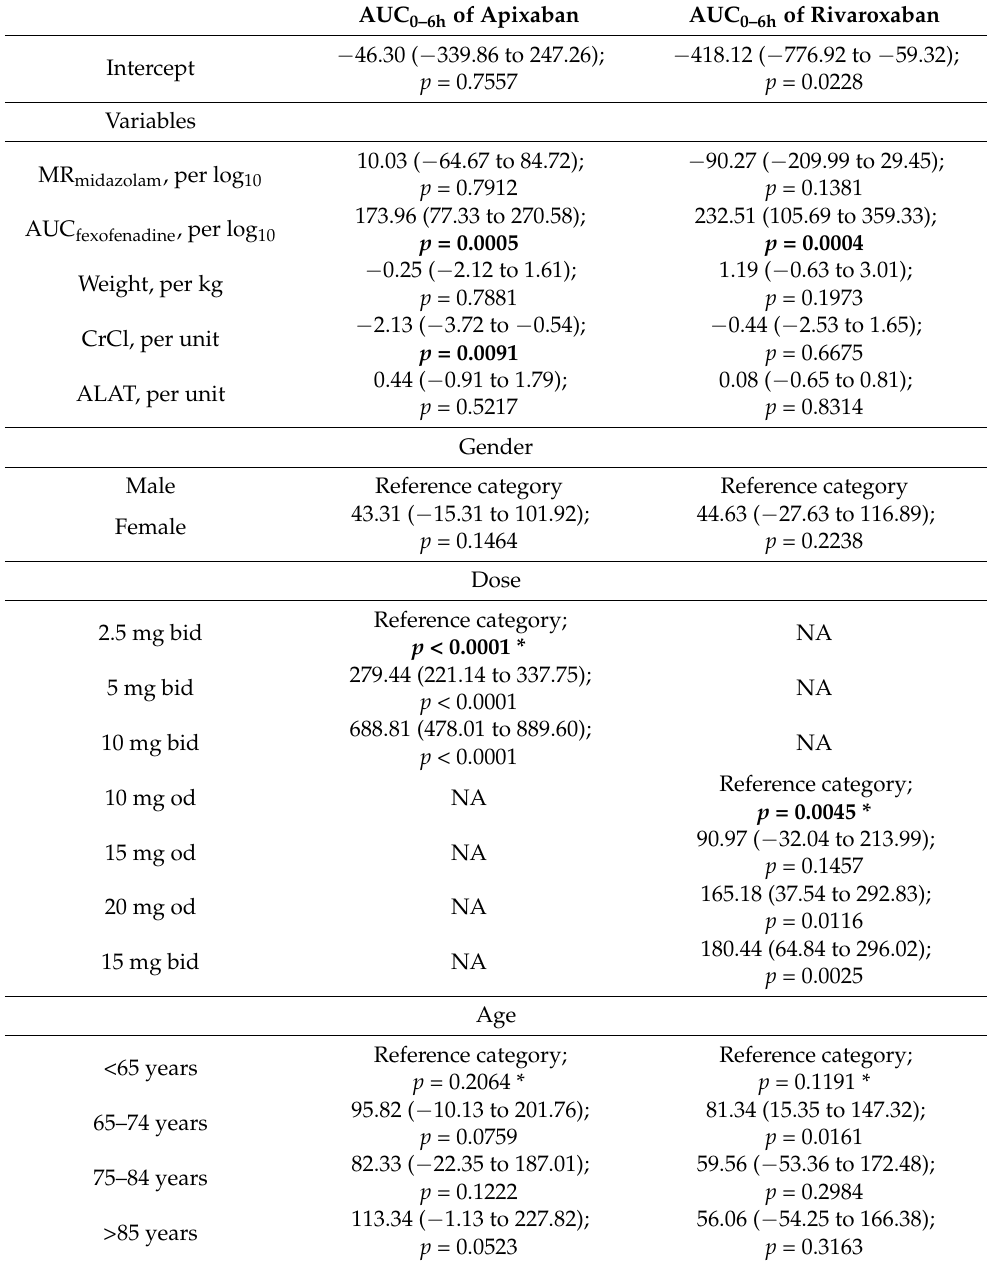
Table 3. Multivariable linear regression models to assess if the phenotypic activity of CYP3A and P-gp are associated with the AUC 0–6h of apixaban and rivaroxaban. Each independent variable is reported with its beta coefficient ( β ) and its 95% confidence interval